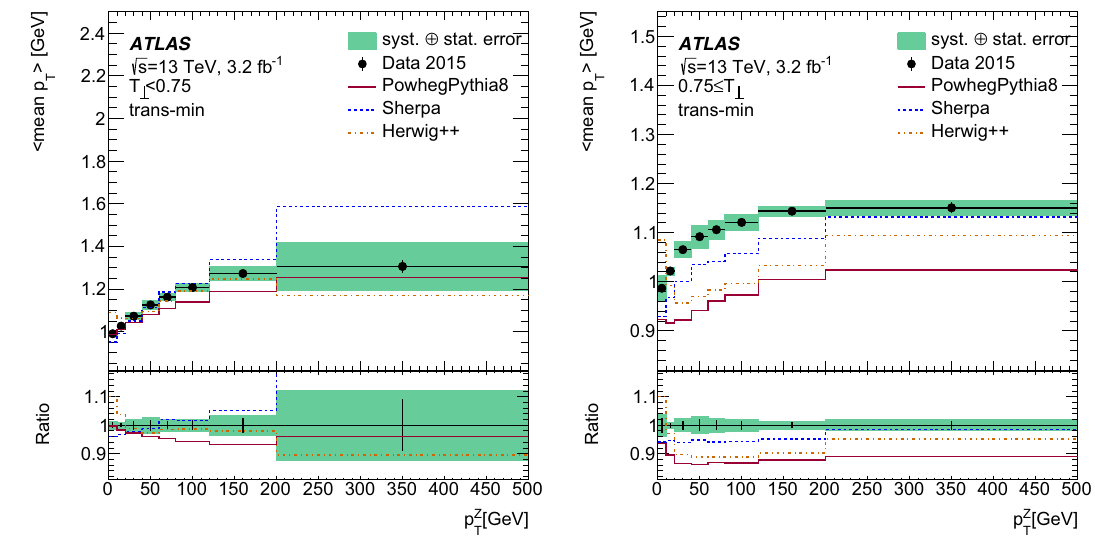
for ranges of T ⊥ in the trans-min region. Predictions of T